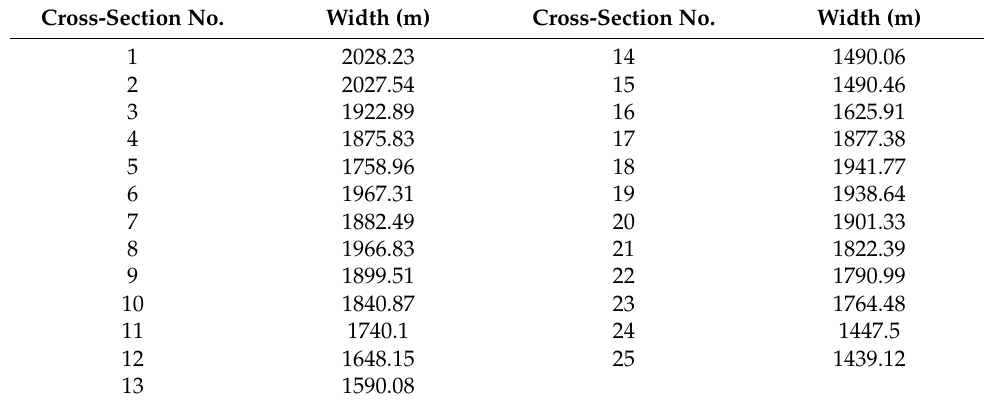
Table 1. River width of 25 cross-sections of the Luoshan reach on 2 May 2021. Cross-Section No. Width (m) Cross-Section